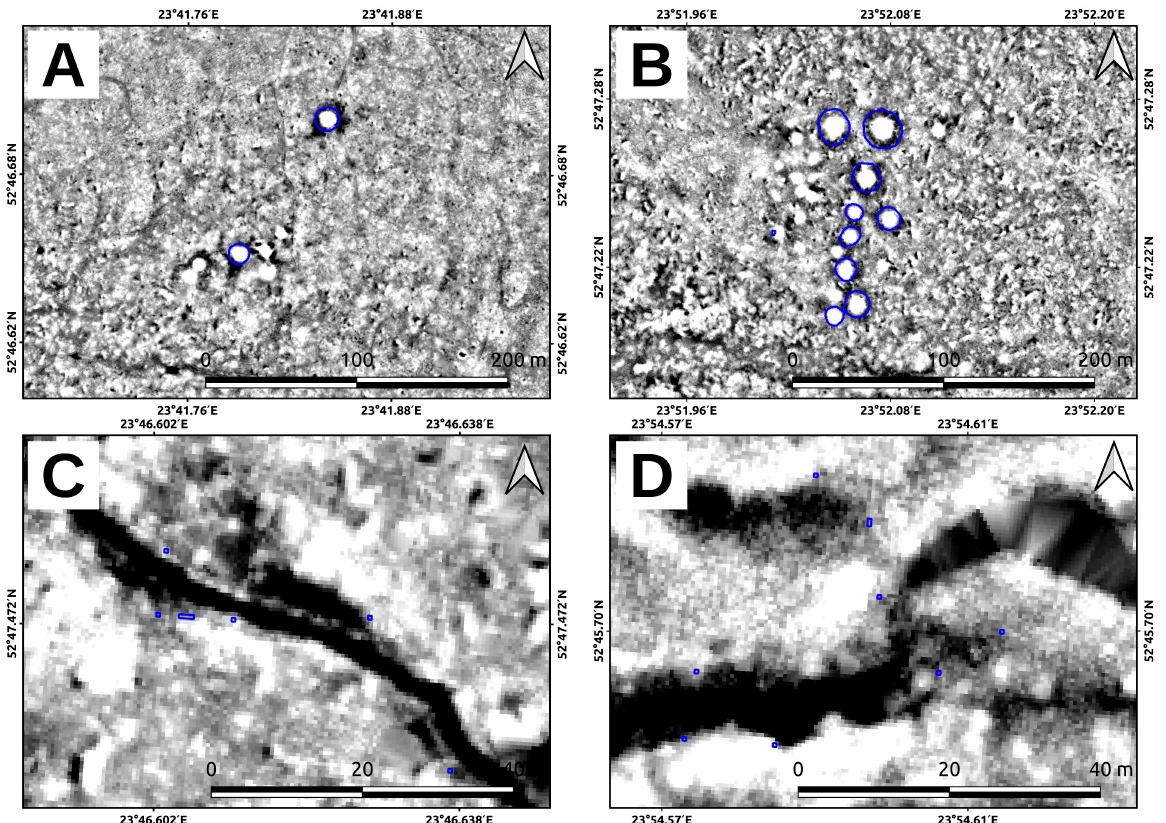
Figure 17. Examples of problems in the segmentation of objects in the burial mounds class (blue outline): ( A , B )—incomplete recognition; ( C , D )—misdiagnoses/noises visible on a large